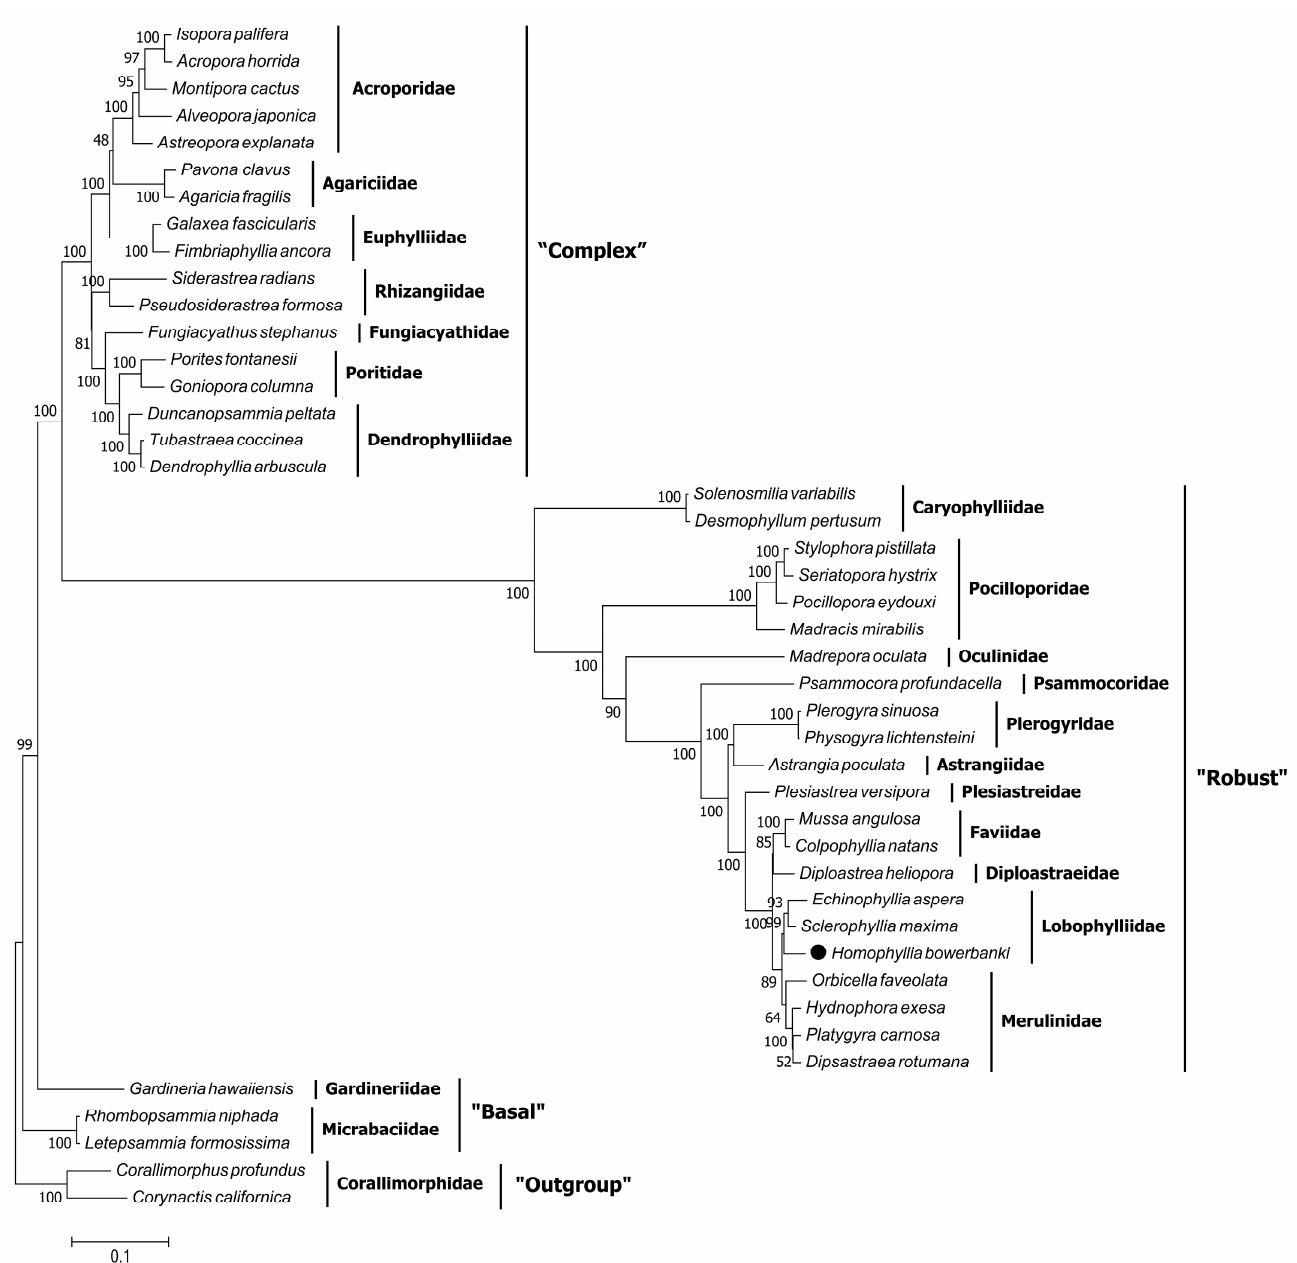
Figure 7. Inferred maximum likelihood phylogenetic tree based on 13 tandem PCGs in mitochon ‐ drial genomes of Homophyllia bowerbanki . Numbers on branches are bootstrap percentages. genomes of H. bowerbanki . Numbers on branches are bootstrap